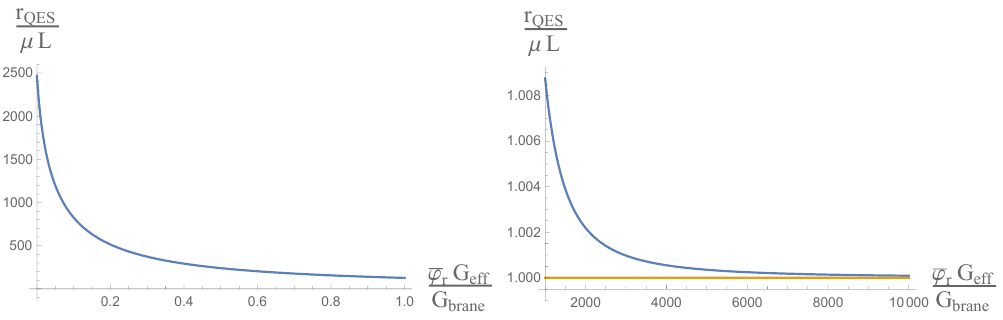
is roughly inveresly proportional µL G brane